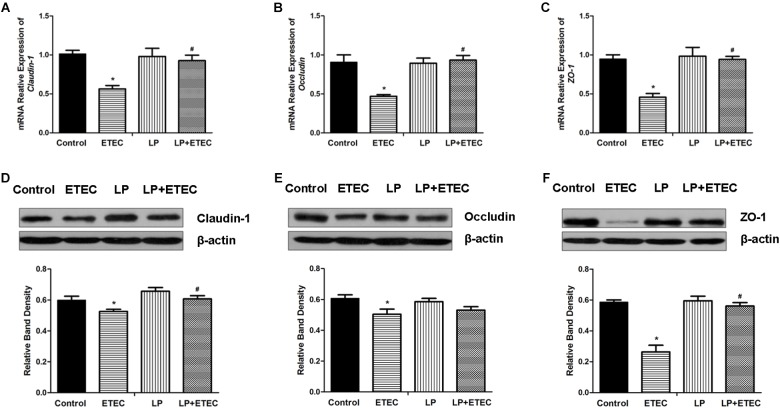
Relative mRNA transcript and protein levels of TJ proteins in IPEC-J2 cells left untreated or pretreated with L. plantarum ZLP001 (LP, 108 CFU mL−1) for 6 h, and then challenged or not with 106 CFU mL−1 ETEC for 3 h. mRNA levels of claudin-1
(A), occludin
(B), and ZO-1
(C) were standardized to that of GAPDH. Expression levels relative to non-treated controls were calculated by the 2−ΔΔCT method. TJ protein levels were assessed by immunoblotting. Data are western blotting results and gradation analysis of claudin-1 (D), occludin (E), ZO-1 (F). Values are shown as the means ± SE of three independent experiments. ∗P < 0.05 vs. non-treated controls; #P < 0.05 vs. ETEC alone.